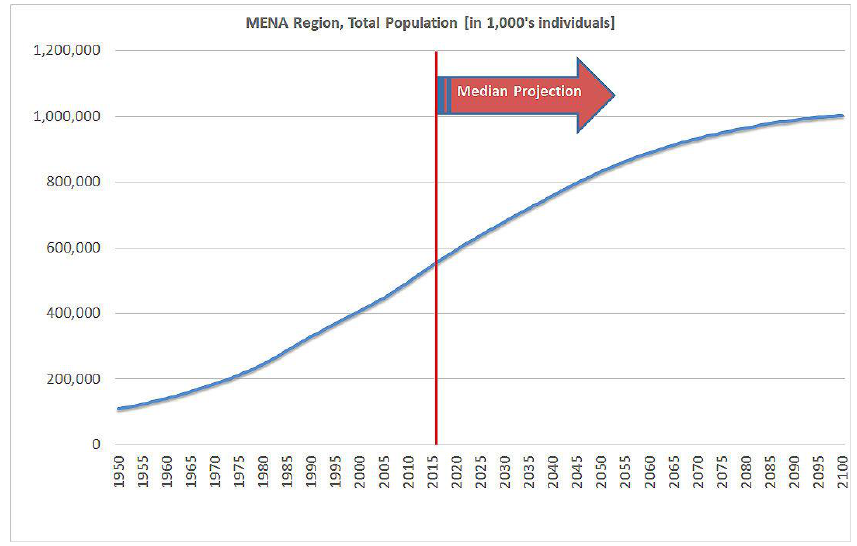
Figure 2. Population development of MENA countries; total population (both sexes combined) annually for 1950–2100 (estimates: 2015–2100); this figure has been developed based on data by